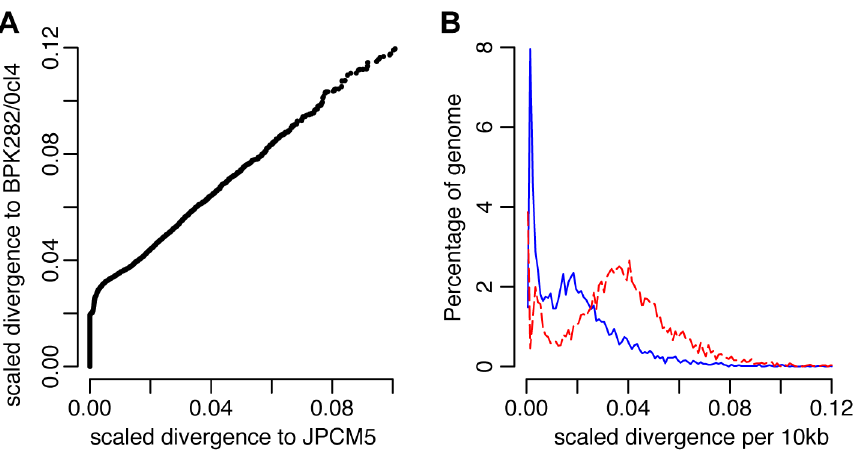
Figure 3. Genome-wide divergence between the CUK strains and other L.donovani complex reference genomes. (A) Divergence between the Turkish population and the L. donovani BPK282/0cl4 and L. infantum JPCM5 reference genomes. Values shown are numbers of SNPs in non-overlapping 10 kb windows, scaled using the divergence to L. major for each window. A higher fraction of blocks show no more difference between the Turkish population and JPCM5 than to BPK282/0cl4, but other blocks are significantly divergent from both references. (B) Frequency distribution of divergence between the CUK strains and the reference genomes, L. infantum JPCM5 (blue solid line) and L. donovani BPK282/0cl4 (red dashed line) for 10 kb windows, scaled using the divergence with L. major . Divergence to JPCM5 shows a significantly bimodal pattern, with sets of very low divergence blocks (mode 0.1 SNPs/kb) and higher divergence (mode 1.7 SNPs/kb), while BPK282/0cl4 divergence cannot reject unimodal high divergence (2.0 SNPs/kb). Genome-wide patterns suggest one ancestor closely related to JPCM5 and a second ancestor not closely related to either of the two references.